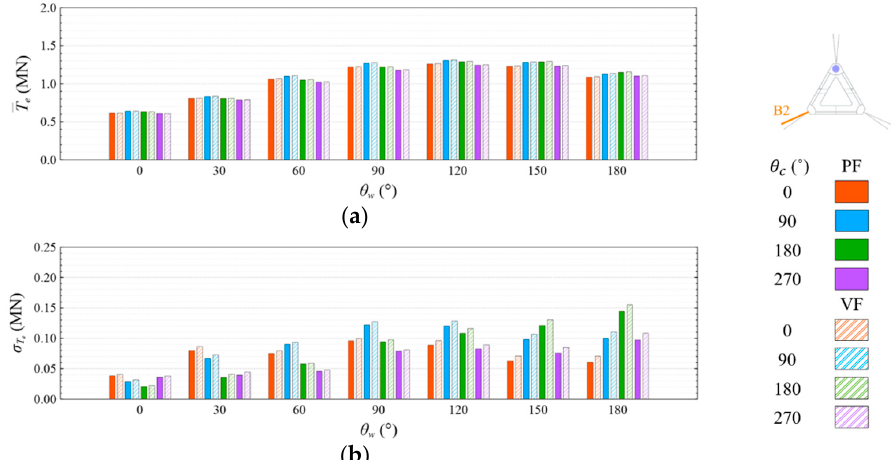
Figure 37. Comparison of ( a ) means and ( b ) standard deviations of mooring line tension of Line B2 under HW condition.